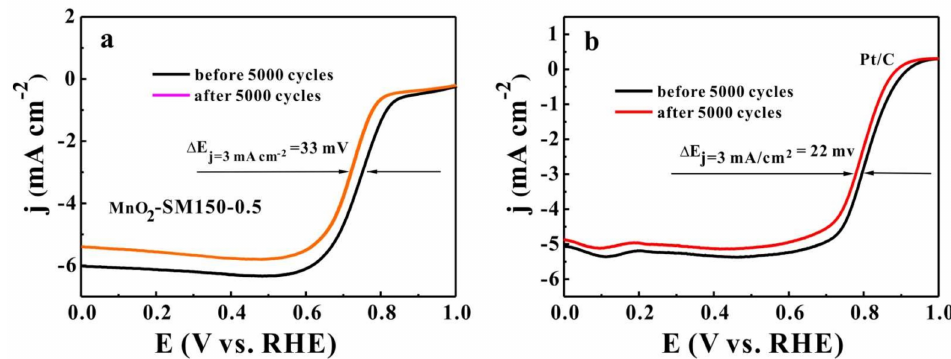
Figure 5. LSV curves of MnO 2 -SM150-0.5 ( a ) and Pt/C ( b ) before and after the accelerated durability test (ADT). The ADT was performed by subjecting the catalyst to 5000 circles from 0.57 V to 0.82 V (vs. RHE) in an O 2 -saturated 0.1 M of KOH solution at room temperature at a scan rate of 100 mV s − 1 .